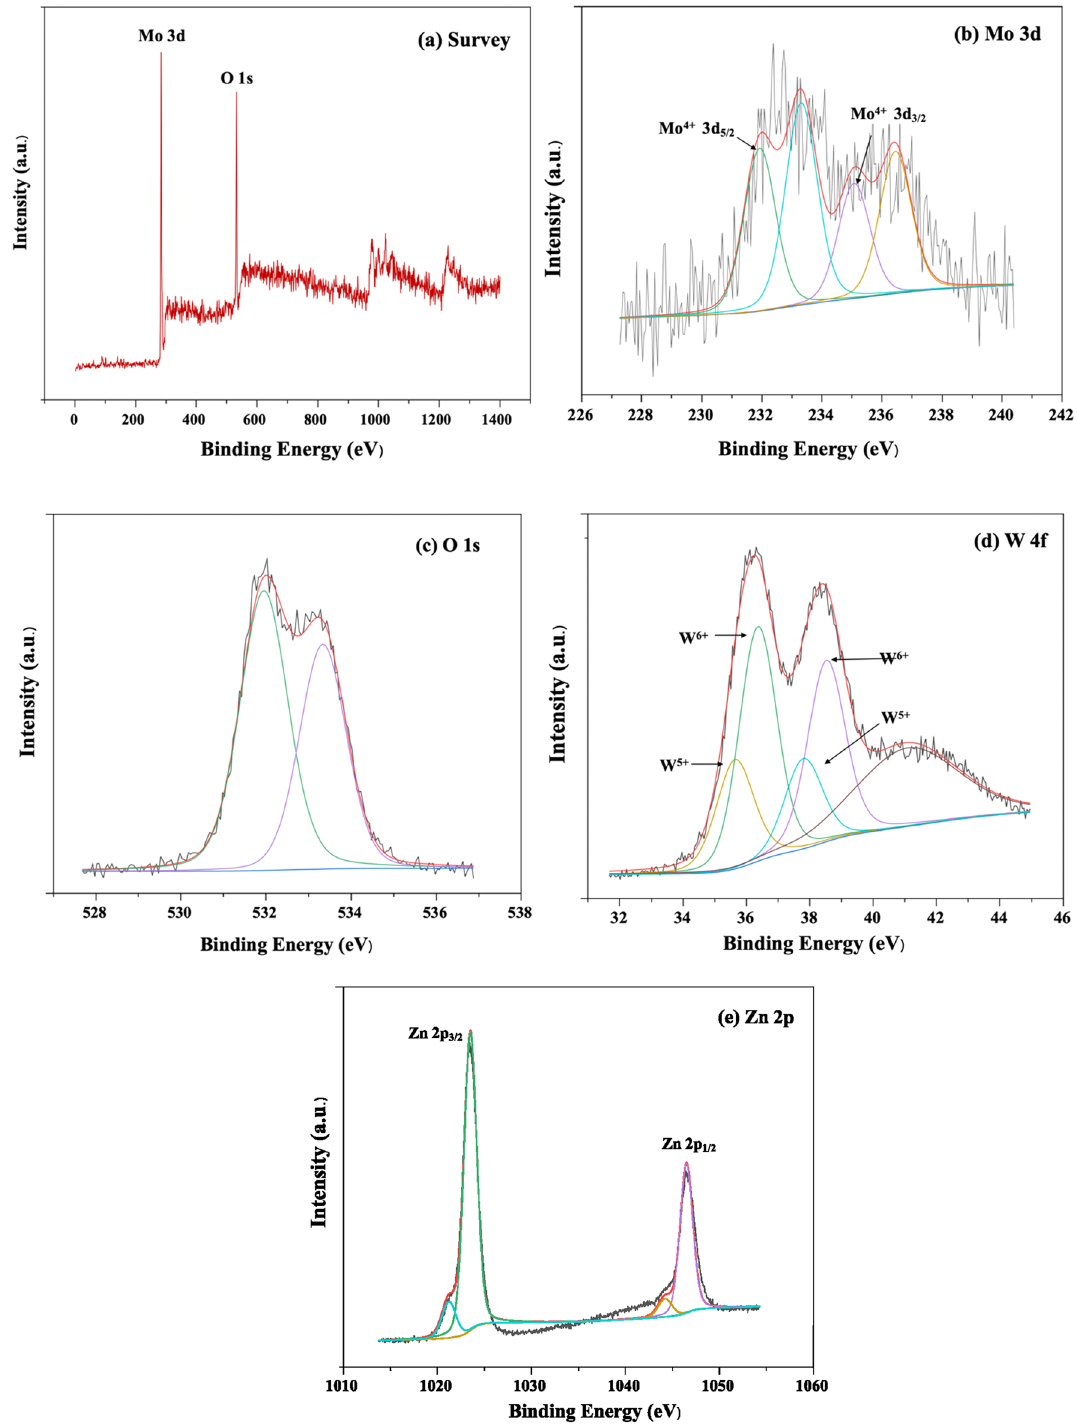
Figure 7. XPS spectra of ( a ) survey, ( b ) Mo 3d, ( c ) O1s, ( d ) W 4f, and ( e ) Zn